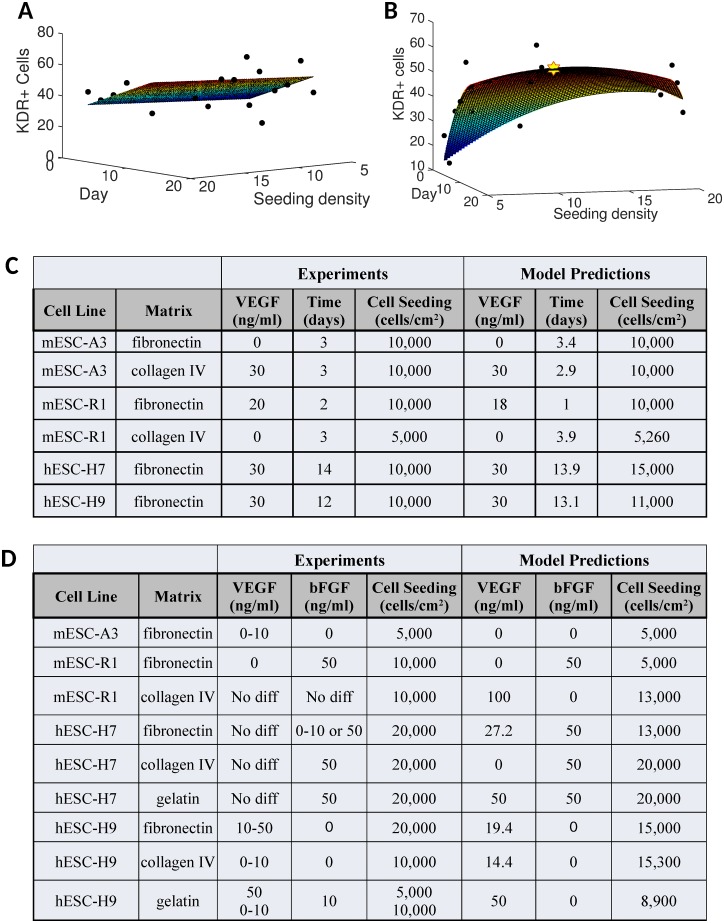
Regression analysis and optimal conditions.Multiple regression analyses using both linear and non-linear models was performed. MATLAB Statistical Toolbox’s fitlm function was then used to estimate the linear model coefficients that best fit our data. A) A representative 3D graph depicts the best fit linear regression model (surface) and the experimental data (black circles) for hESC-H9 on fibronectin at fixed VEGF but varying time and cell seeding densities. B) Representative graph with the same data, but fitted with a non-linear model to identify optimal values (yellow star) of significant variables that maximize KDR+ expression. Experimental optima are presented along with model predictions for C) stage 1 inductions of ESC into VPC and D) stage 2 inductions of VPC into EC.